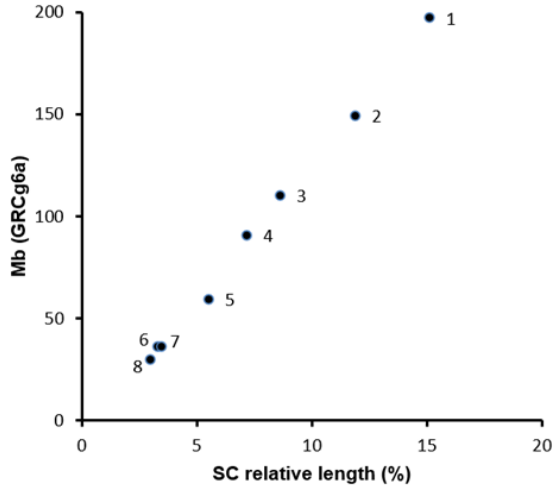
Figure 2. Relationship between macrochromosome sizes and SC length. The size of each macrochromosome in the genome assembly (galGal6) are in Mb; the SC lengths are expressed as a percentage of the total SC set. A regression test show that both parameters are significantly correlated (Pearson regression test, r = 0.988; p < 0.0001).